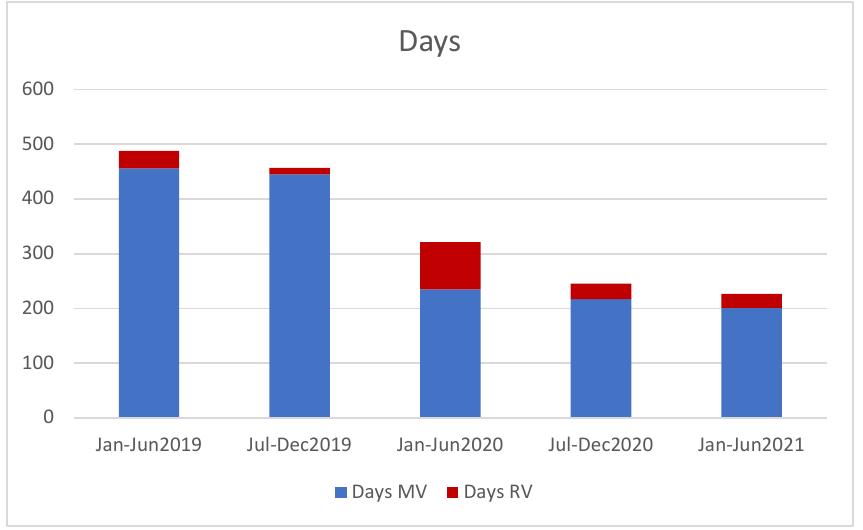
Figure 3. Monitoring activity in person (MV) and remotely (RV) by CTI central office staff, per 6 month period.